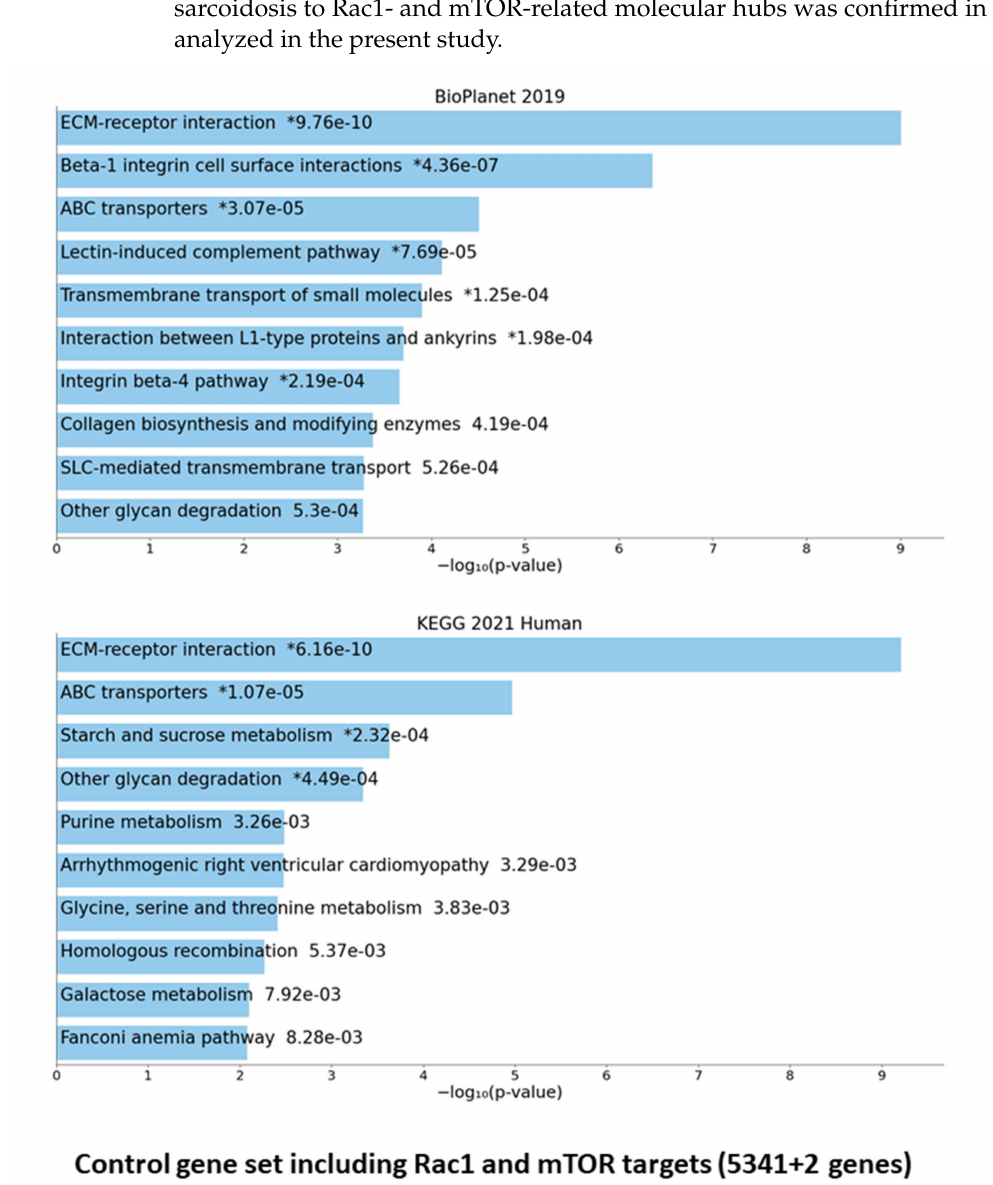
Figure 3. Gene set enrichment analysis of the top 10 genes obtained through BIOPLANET-2019 (NIH-USA, National Center for Advancing Translational Science) and KEGG-2021 (Kyoto Encyclopedia of Genes and Genomes) in the CONTROL gene set including the Rac1 and mTOR anchors. For this, the Rac1 and mTOR terms were included in the list of the CONTROL gene set inside ENRICH.R. The bar chart shows the top 10 enriched terms in the chosen library, with their corresponding p -values. Colored bars correspond to terms with significant p -values (<0.05). An asterisk (*) next to a p -value indicates the term also has a significant adjusted p -value